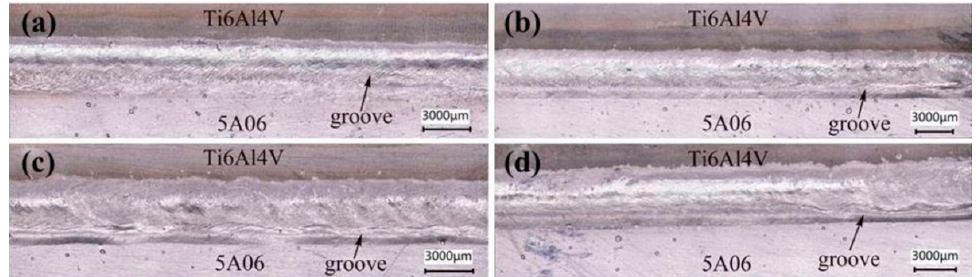
Figure 9. Influence of laser power on weld seam appearance: ( a ) 1080 W; ( b ) 1130 W; ( c ) 1180 W; ( d ) 1230 W.